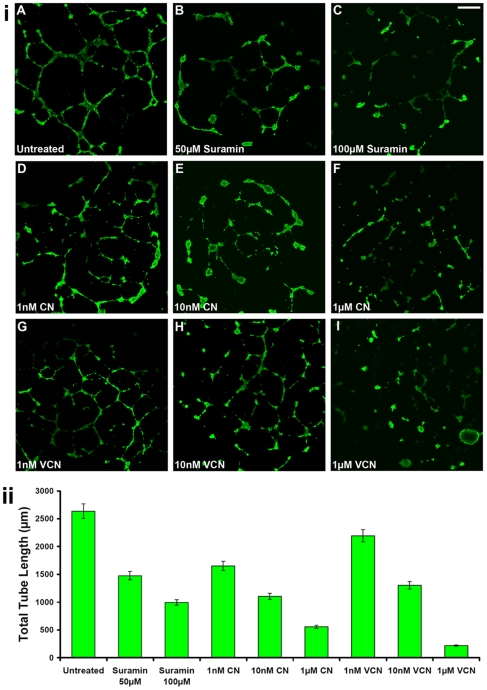
VCN inhibits HUVEC tube formation (tubulogenesis).(i) HUVEC were plated on ‘Endothelial Cell Tube Formation’ plates (BD Biosciences) in the presence of various concentrations of either CN or VCN (1–1000 nM) and allowed to form tubes after incubation for 12–16 hr at 37°C in the presence of 5%CO2. Suramin, a known tube formation inhibitor, was used as a positive control at two different concentrations (50 and 100 µM). At the end of the incubation period, cells were stained with Calcein AM and imaged by confocal microscopy (magnification, ×25). Representative figures from three independent experiments are shown above (scale bar, 200 µm). (ii) The degree of tubulogenesis was assessed by capturing multiple photomicrographs for all conditions on which the total length of the tubes was measured and computed in multiple fields using the Zeiss LSM Image Browser (Carl Zeiss MicroImaging GmbH) and then averaged to form each data point. The data presented above was assembled from three independent experiments.